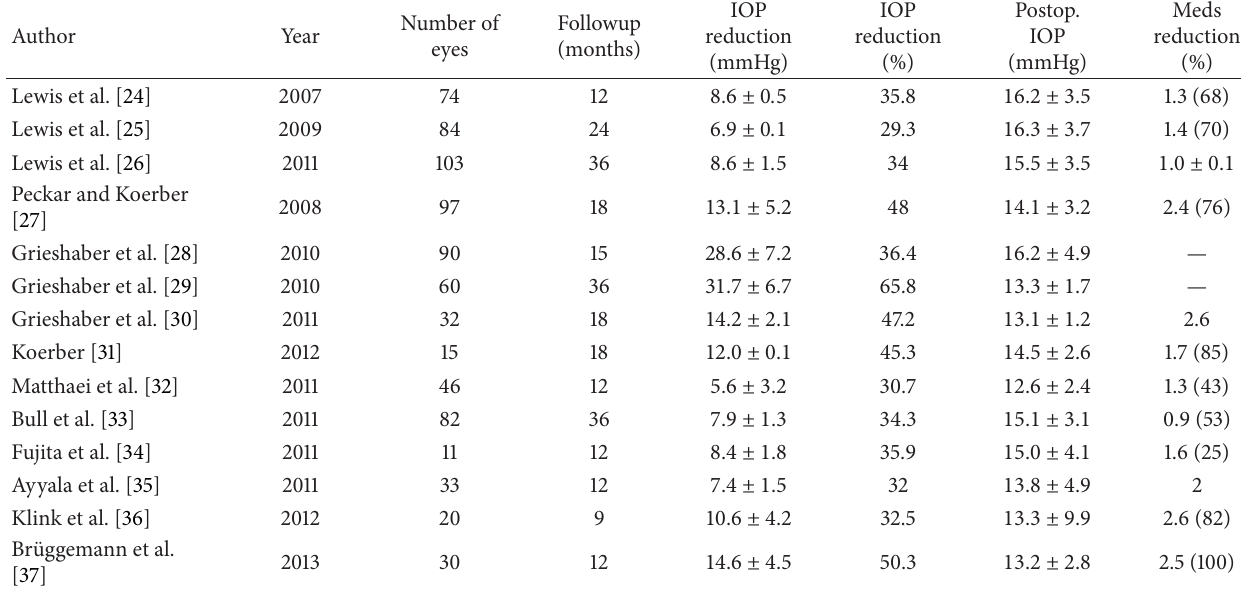
Table 7: Canaloplasty alone.